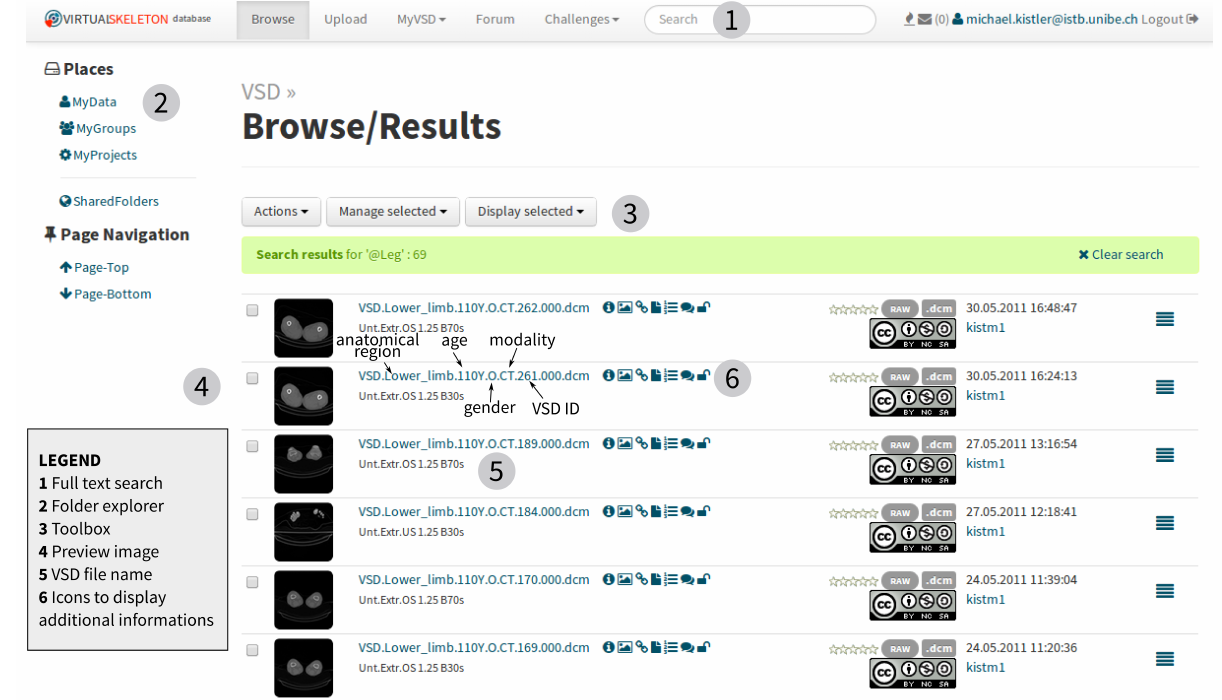
Figure 4. VSD Web interface to browse data with folder explorer: MyData=Location of the user’s uploaded data; MyGroups=Default collaboration folder accessible to all group members; MyProjects=Folders to organize data into personal projects; SharedFolders=Folders of other VSD members which are shared to the